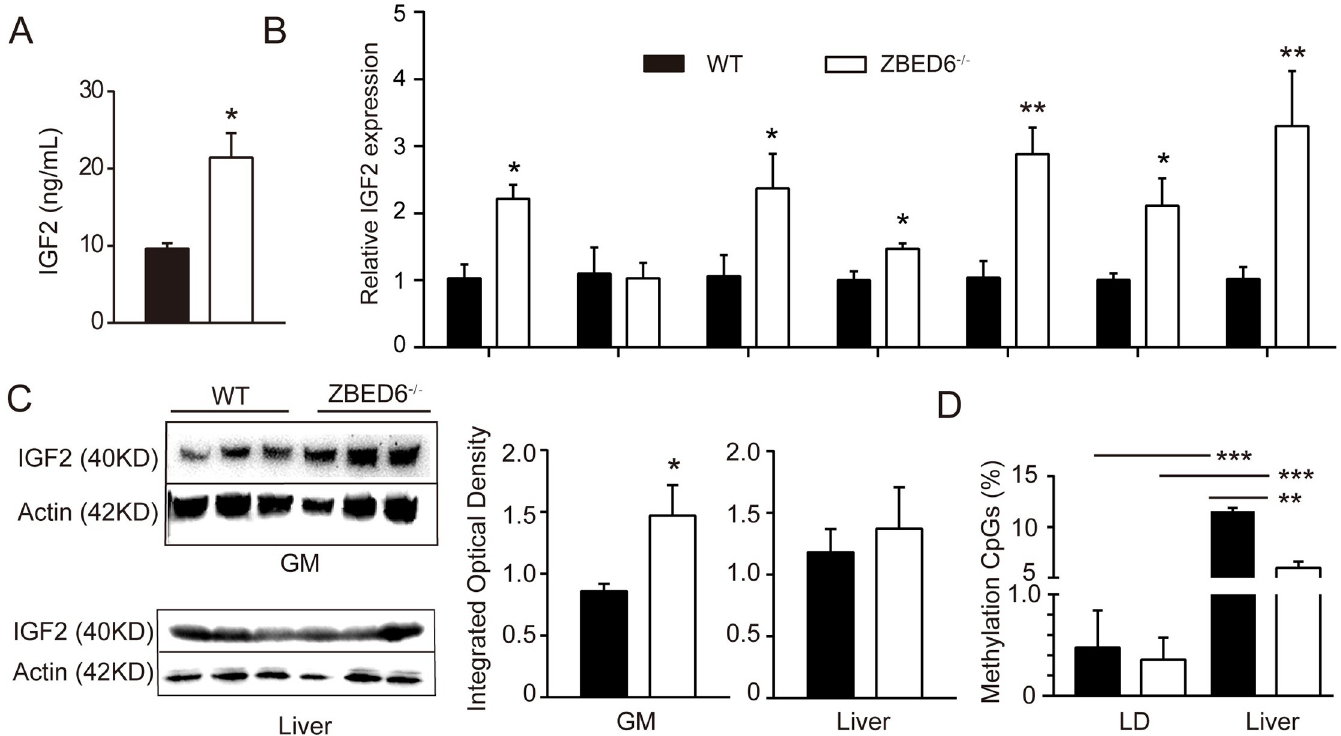
Fig 3. Increased levels of IGF2 in multiple tissues except liver in WT and ZBED6 -/- pigs (n = 3). Gastrocnemius muscle (GM), longissimus dorsi (LD). (A) Serum concentrations of IGF2 in WT and ZBED6 -/- pigs at 3 months (B) qPCR analysis of IGF2 mRNA in multiple tissues from ZBED6 -/- pigs. (C) Western blot analysis of IGF2 in GM and liver of ZBED6 -/- pigs. Results of western blot were quantified by Iamge J. The relative levels of IGF2 protein in GM and liver were plotted. (D) Percentage methylation around IGF2 -intron 3–3072 (GCTCG) of LD and liver in WT and ZBED6 -/- . The results are the means ± SEMs. � p < 0.05; �� p < 0.01, ��� p < 0.001, Student’s t